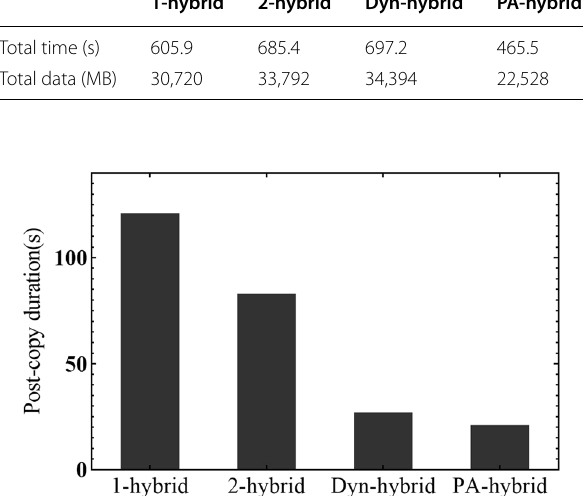
Fig. 12 Post-copy